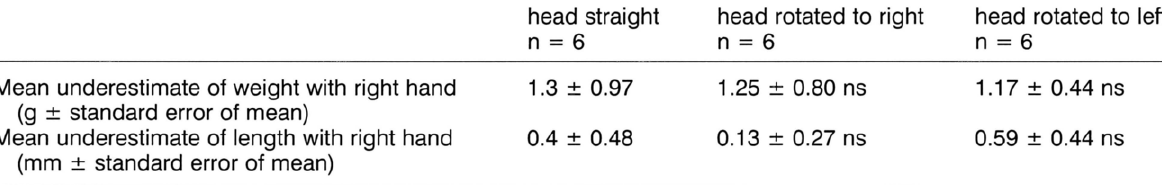
head rotated to right head rotated to left head straight n=6 n=6 n=6 1.3 ± 0.97